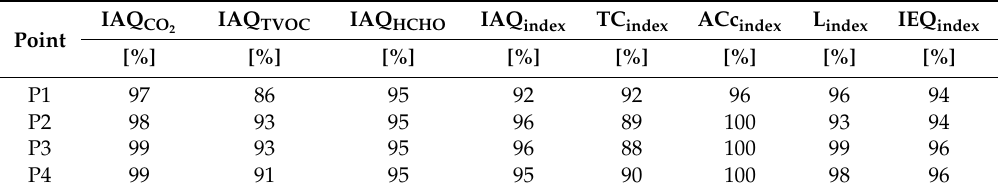
Table 8. List of predicted occupant satisfaction indices (in each IEQ category) for four building measurement